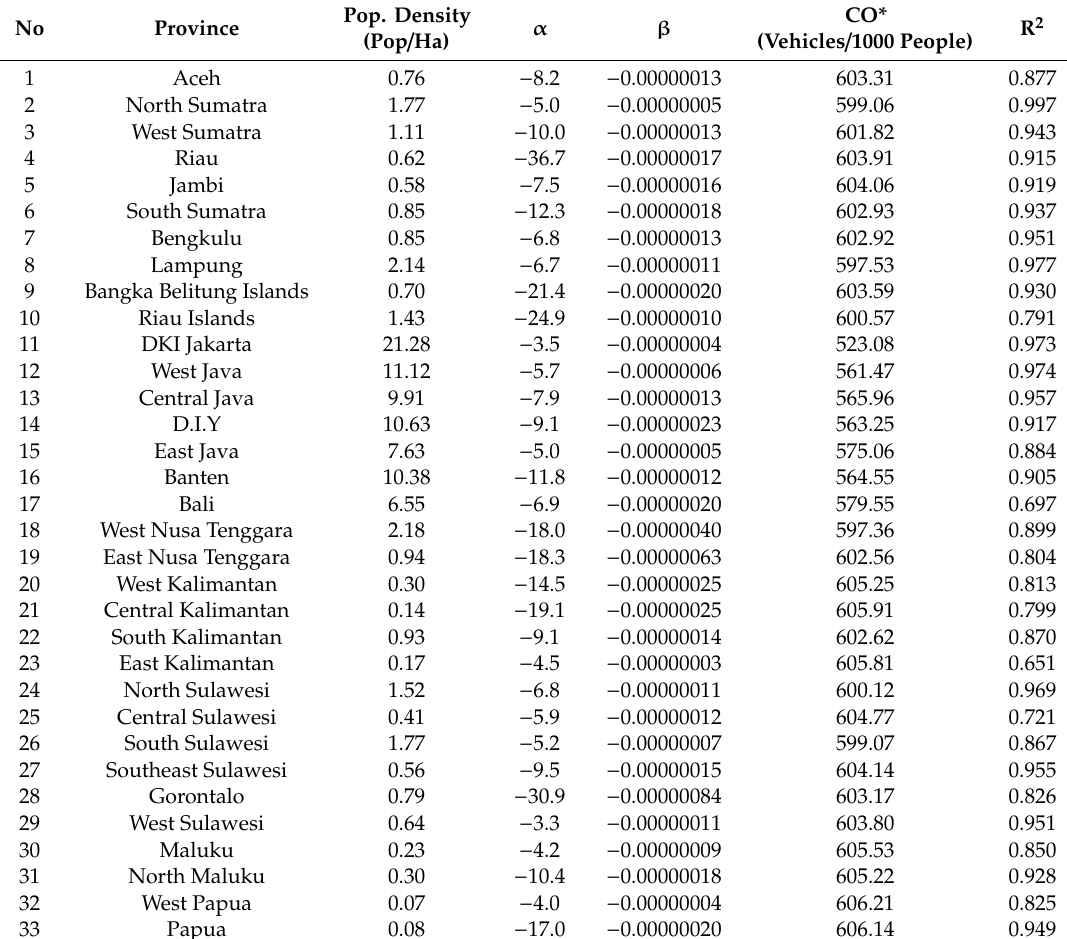
Table 6. Results of car ownership analysis by province using the Gompertz